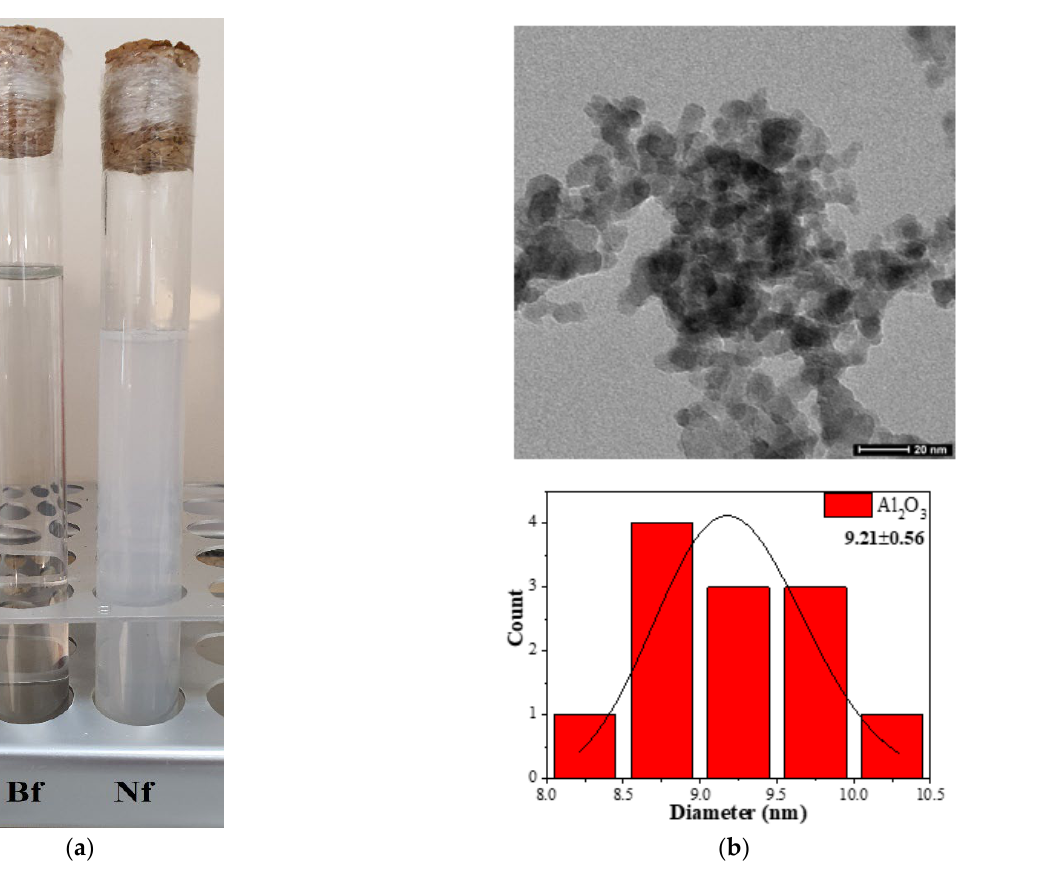
Figure 3. Test section’s detailed schematic drawing.